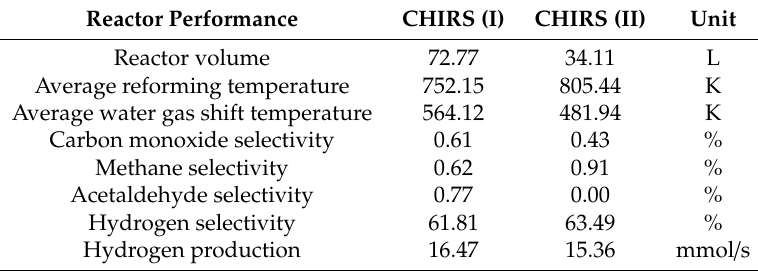
Table 2. Process performance of CHIRS (I) and CHIRS